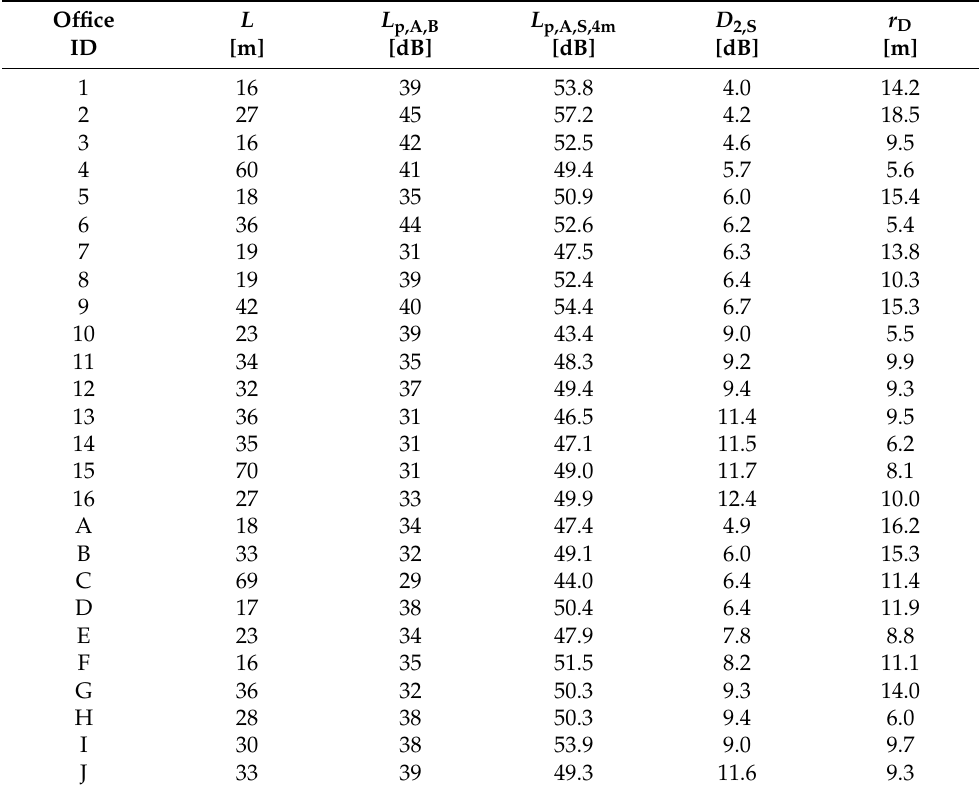
Table 1. The data of the 26 offices of Ref. [17] used in our study. L is the length of the office in the direction of the measurement path. The other quantities were defined in Section 1. The notation (both numbers and letters) is adopted from Ref.